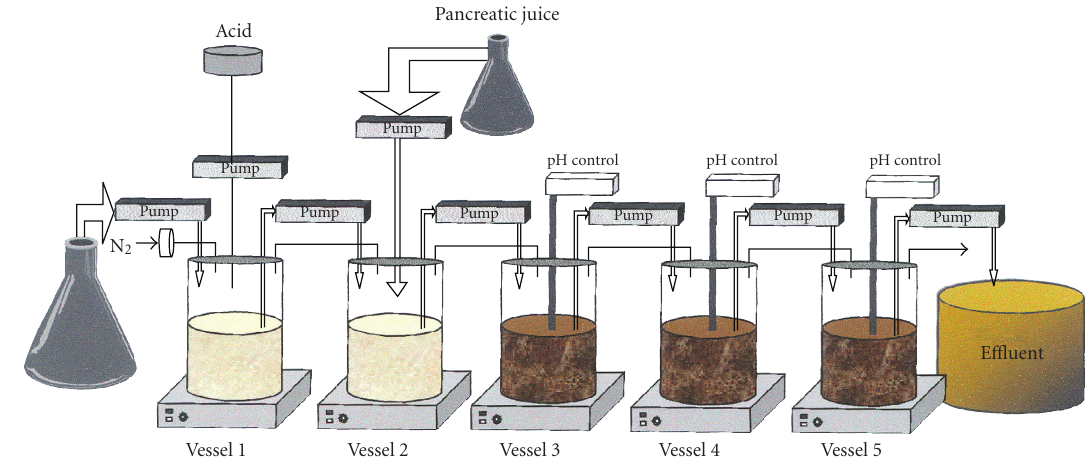
Figure 1: Computer-controlled dynamic human GI model. Bioreactors in series representing stomach (Vessel 1), small intestine (Vessel